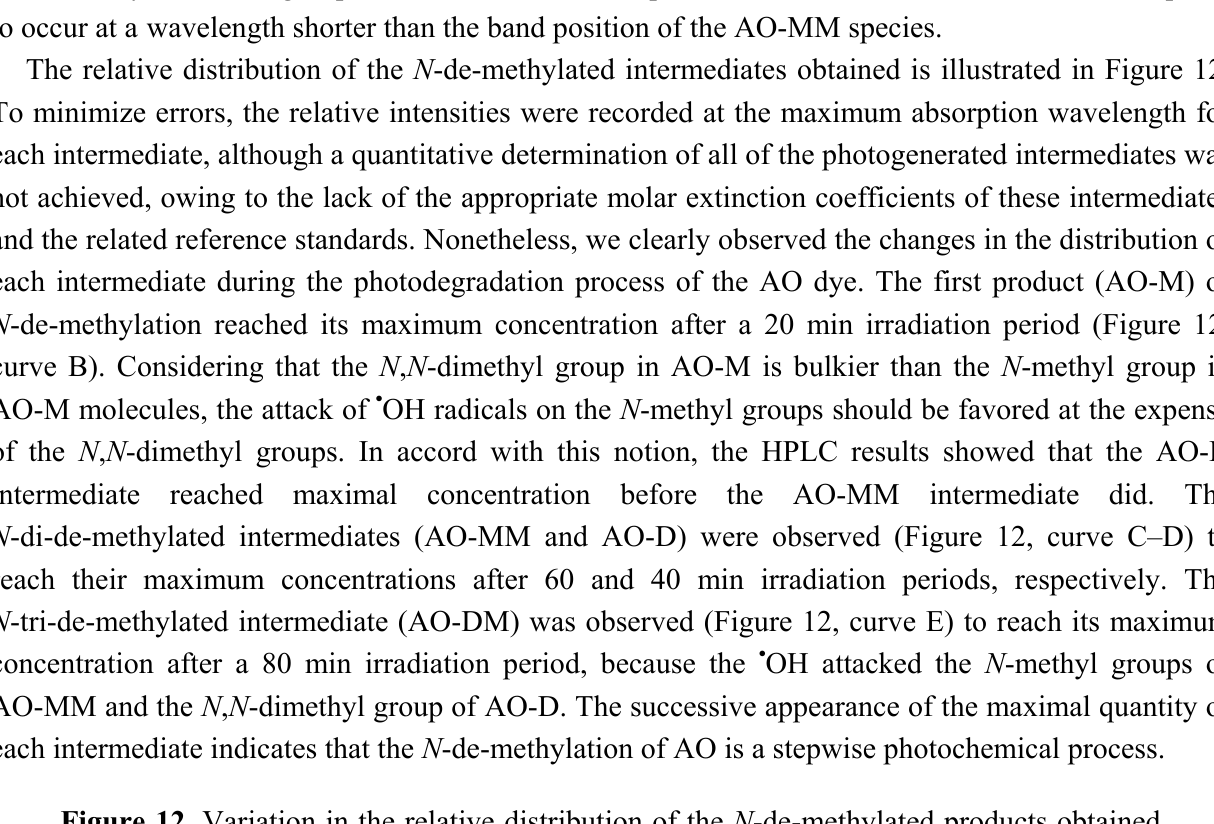
Figure 12. Variation in the relative distribution of the N -de-methylated products obtained from the photodegradation of the AO dye as a function of the irradiation time. Curves B–F correspond to the peaks B–F in Figure 9,